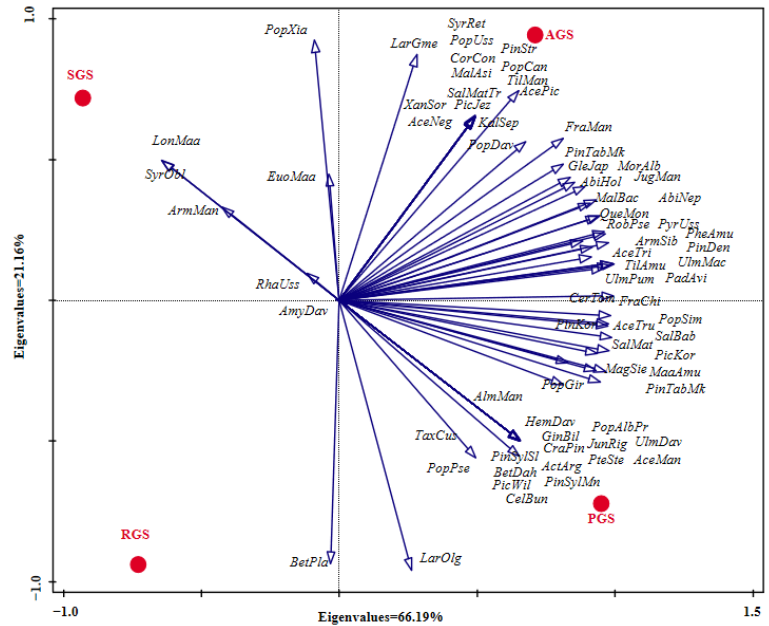
Figure 4. PCA analysis of the species composition among different types of green spaces. RGS, road green spaces; AGS, attached green spaces; PGS, park green spaces; SGS, square green spaces. For abbreviations of species names, refer to Table A1.